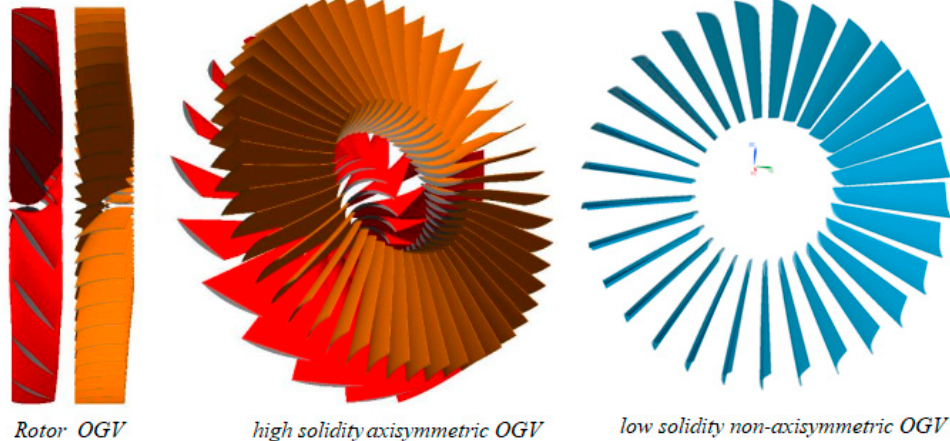
Figure 24. Non-axisymmetric OGV defined using lean for a boundary layer ingestion Figure 24. Non ‐ axisymmetric OGV defined using lean for a boundary layer ingestion fan.